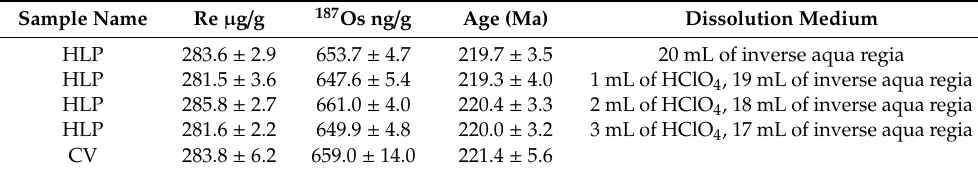
Table 3. Analytical results for 1 g of pyrite mixed with HLP in 20 mL of combined